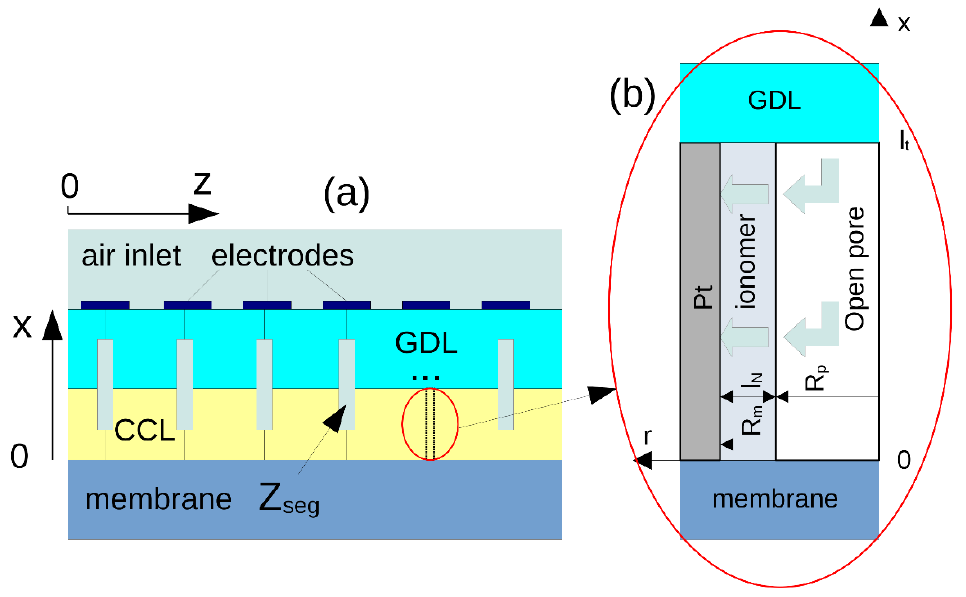
Figure 2. Schematic of the cell with segmented electrodes and gas diffusion layer ( a ). Sketch of a single pore used to model cathode catalyst layer impedance ( b ).